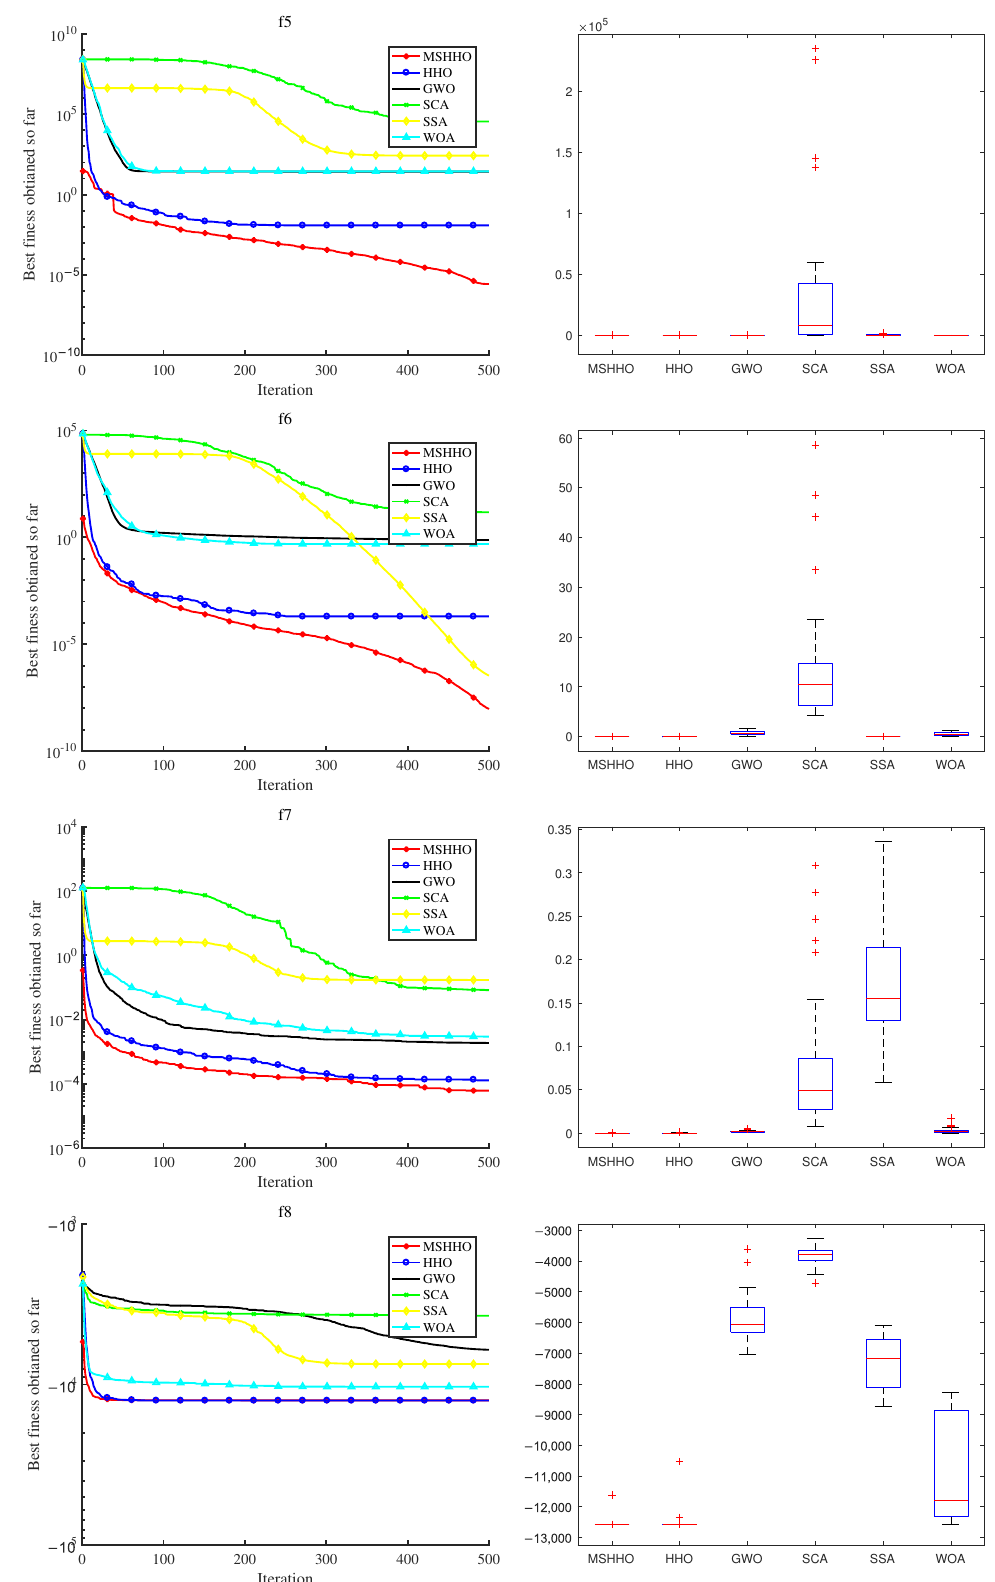
Figure 6. Qualitative results of F5, F6, F7, and F8